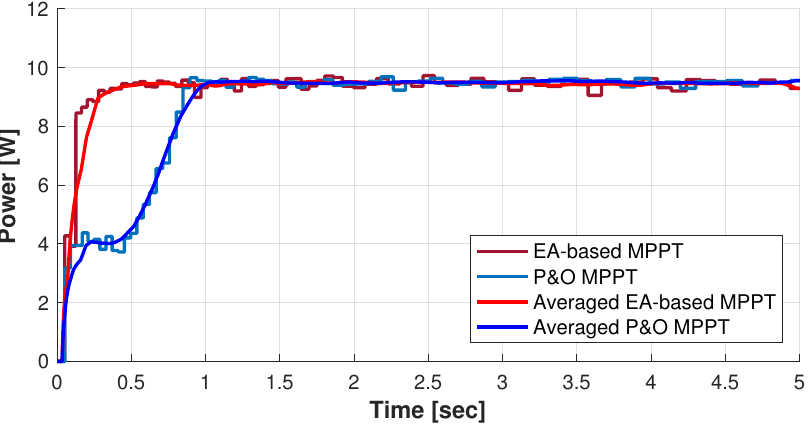
Figure 34. Averaged experimental performance of the MPPT algorithms, comparing the EA-based MPPT and P&O